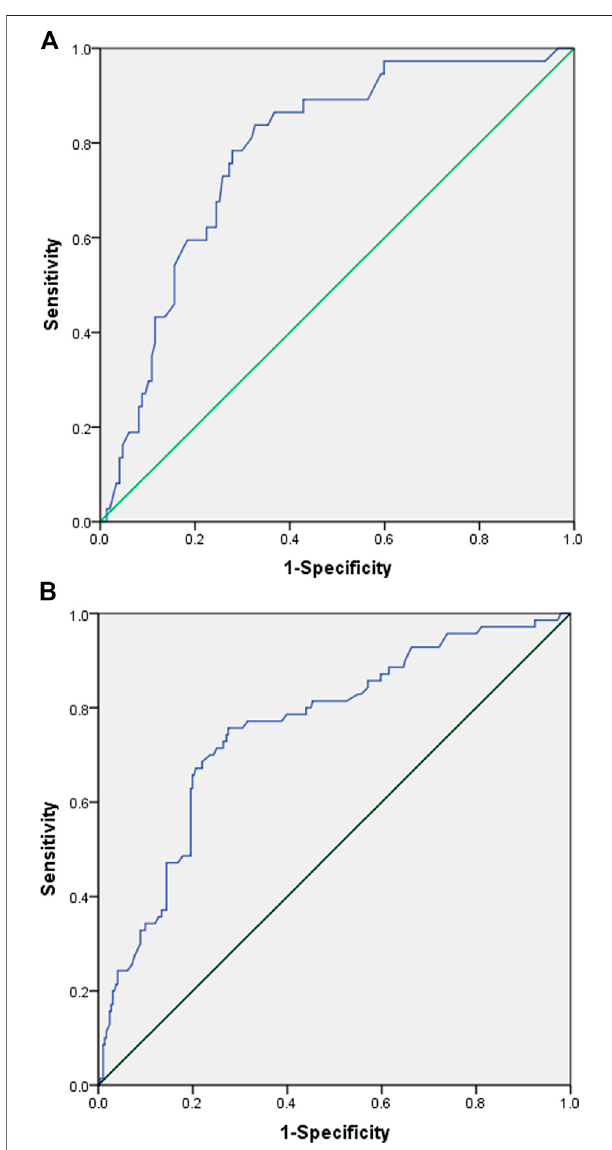
FIGURE 2 | Receiver operating characteristic (ROC) curve of linezolid- induced adverse effect. (A) ROC curve of low hemoglobin 1 – 7 days after the end of linezolid administration. (Youden index = 0.511, cut-off values = 120.69, area under the ROC curve = 0.783, 95% con fi dence interval=(0.706-0.860), p < 0.001, sensitivity = 0.838, speci fi city = 0.673). (B) ROC curve of thrombocytopenia 8 – 15 days after the end of linezolid administration. (Youden index = 0.482, cut-off values = 92.88, area under the ROC curve = 0.756, 95% con fi dence interval=(0.693-0.820), p < 0.001, sensitivity = 0.757, speci fi city = 0.725).